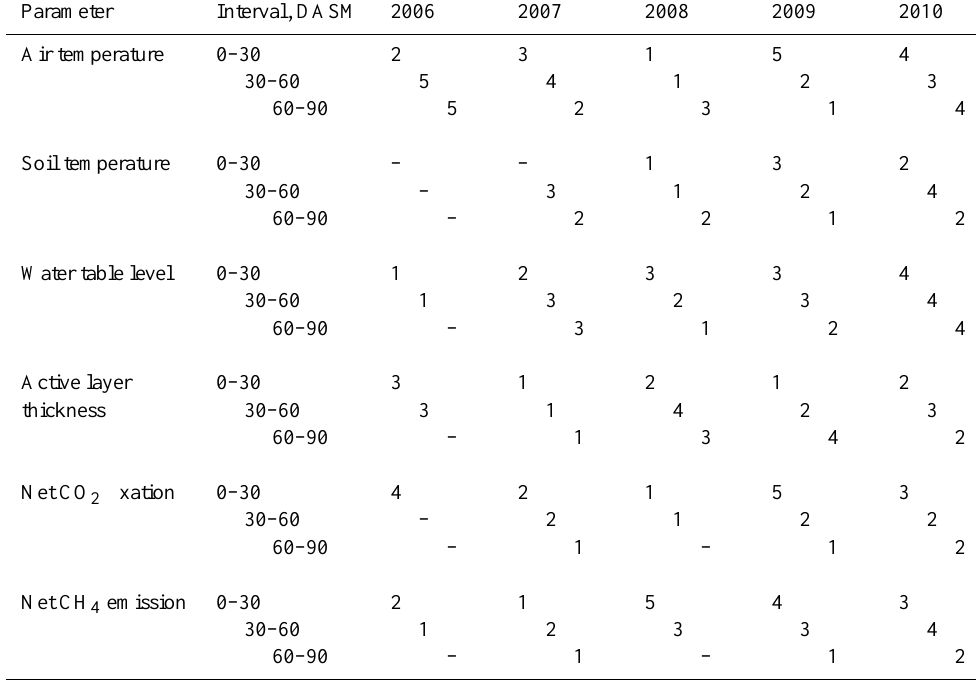
Table 2. Ranking of 2006–2010growing seasons in environmental conditions, CO 2 and CH 4 fluxes. Rank 1 means highest values, similar ranks mean close